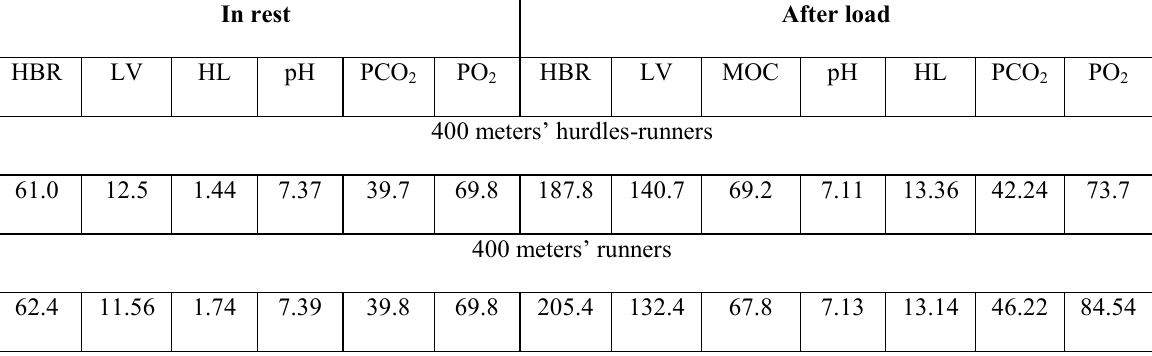
Comparative characteristic of physiological and biochemical indicators, taken in process of work on treadmill, of 400 meters runners and 400 meters’